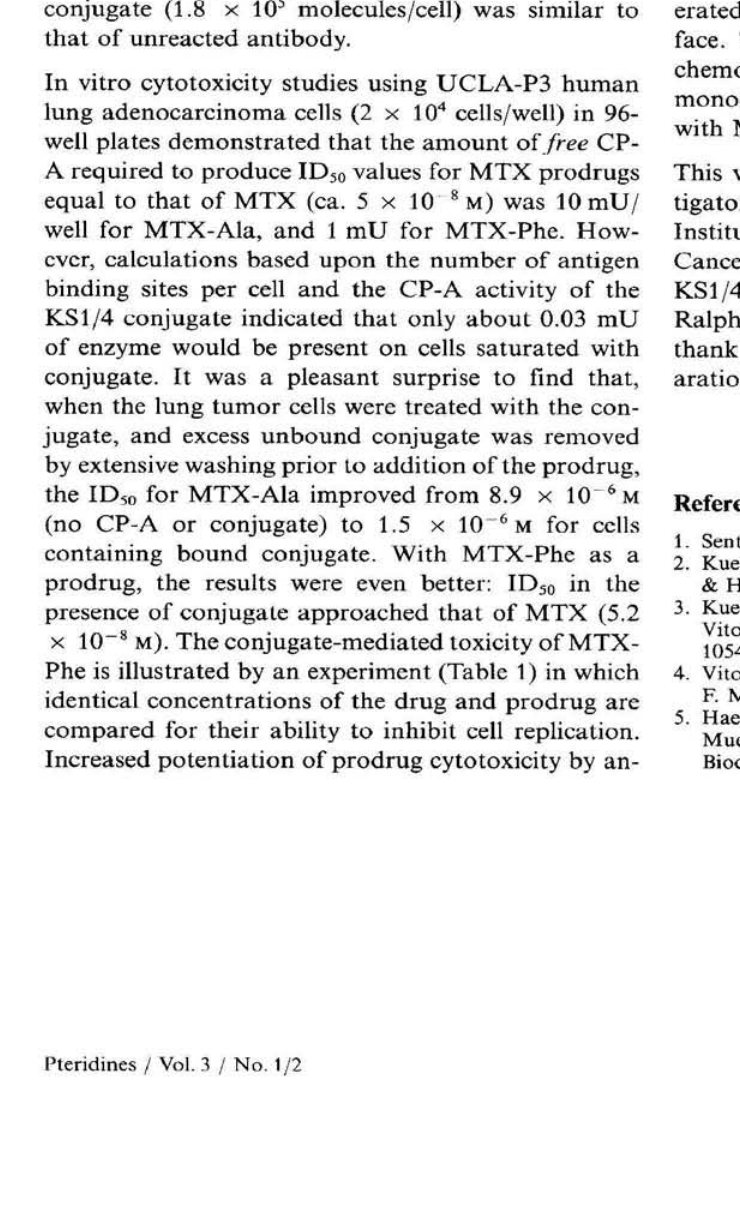
Table 1. Cytotoxicity of Methotrexate α-Phenylalanine (MTX- Phe) for UCLA-P3 Cells Treated with Carboxypeptidase-A (CP-A)/Monoclonal Antibody KS1/4 Conjugate Drug Enzyme- % or Prodrug Monoclonal Inhibition Conjugate MTX 100 MTX-Phe CP-A/KSl/4 94 MTX-Phe — 23 — CP-A/KSl/4 3 In vitro cytotoxicity against UCLA-P3 human lung adenocar- cinoma cells (10 4 cells/well) was measured in 96-well plates as described previously (5). In samples treated with enzyme-anti- body conjugate, excess of the latter was removed by extensive washing. Growth was stopped after 72 h. Inhibition is expressed relative to that observed with MTX (designated as 100%). Concentrations of MTX and MTX-Phe, 1 χ ΙΟ" 6